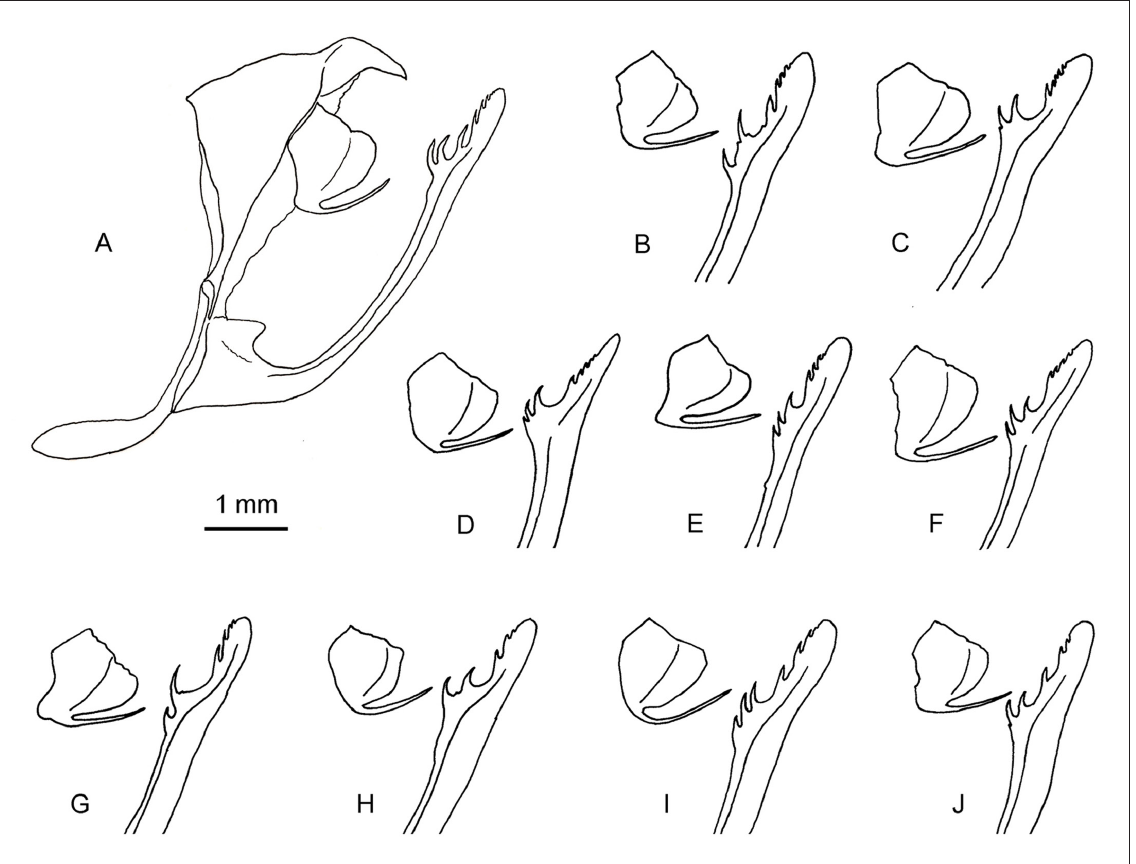
Fig. 12. Male genitalia of various specimens of Eryphanis zolvizora chachapoya ssp. nov. A . PT